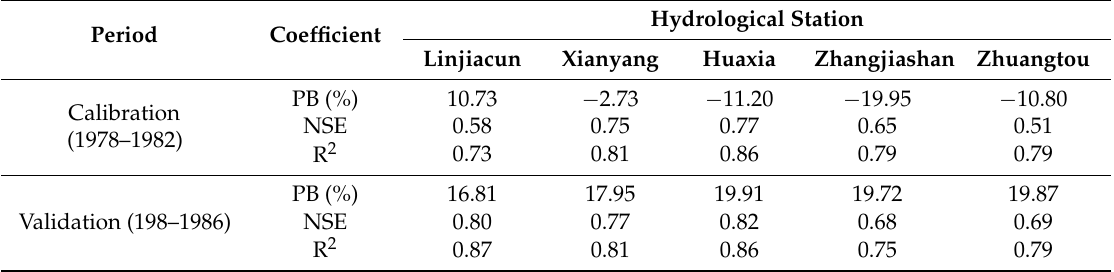
Table 7. Results for the three statistical indicators at the five hydrological